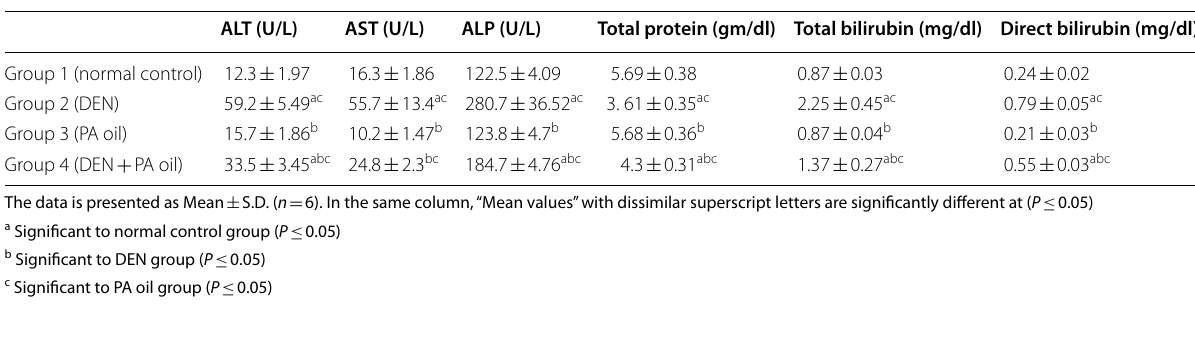
Table 2 Effect of PA oil and/or DEN on liver function test in normal rats ALT (U/L) AST (U/L) ALP (U/L) Total protein (gm/dl) Total bilirubin (mg/dl) Direct bilirubin (mg/dl) Group 1 (normal control) 12.3 ±